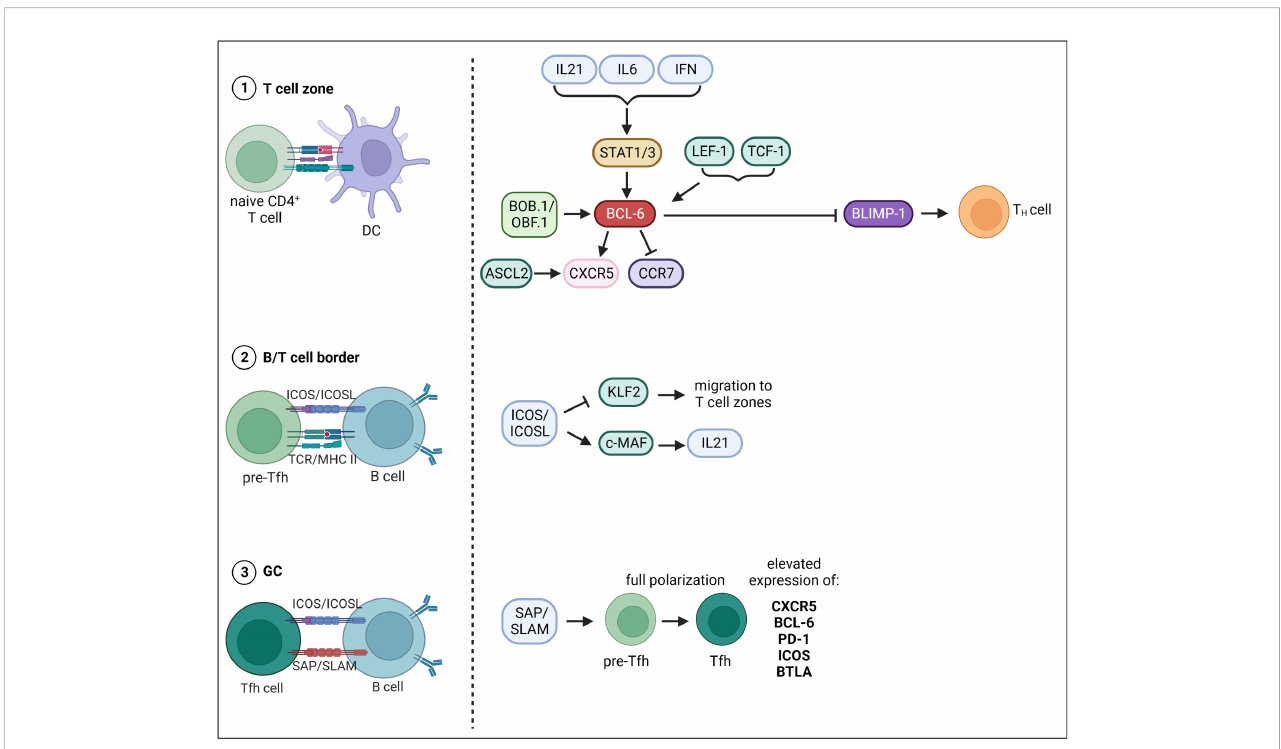
FIGURE 2 Transcriptional control of Tfh cell differentiation. Tfh cell differentiation occurs in three main steps. The fi rst step of Tfh cell differentiation is the interaction of naïve CD4 + T cells with DCs in the T cell zone. The expression of BCL-6, master TF of Tfh cells, is induced on multiple levels. Cytokines including IL-21, IL-6 and type I IFNs (IFN-a/b) drive Bcl-6 expression via the activation of STAT1/3. Besides, TFs LEF-1 and TCF-1 as well as the transcriptional co-activator BOB.1/OBF.1 together with TFs Oct-1/Oct-2 induce Bcl- 6 expression. BCL-6 in turn represses Blimp-1 and TFs favoring development into TH subpopulations. BCL-6 and the TF ASCL2 induce the expression of CXCR5 and suppresses CCR7 expression inducing migration of pre-Tfh cells to the B/T cell border. The second step of Tfh cell differentiation then occurs upon interaction of pre-Tfh cells with Ag-speci fi c B cells in the B/T cell border. ICOS/ICOSL signaling represses the TF KLF2 thereby inhibiting migration back to the T cell zones. ICOS signaling also induces the TF c-MAF, which facilitates IL21 expression. The third step of differentiation occurs within GCs, where SLAM/SAP binding is required to stabilize B/T cell interactions. Here, pre-Tfh cells differentiate into Tfh cells, a further polarized state characterized by highest expression levels of BCL-6, CXCR5, PD-1, ICOS and BTLA. This fi gure was created with